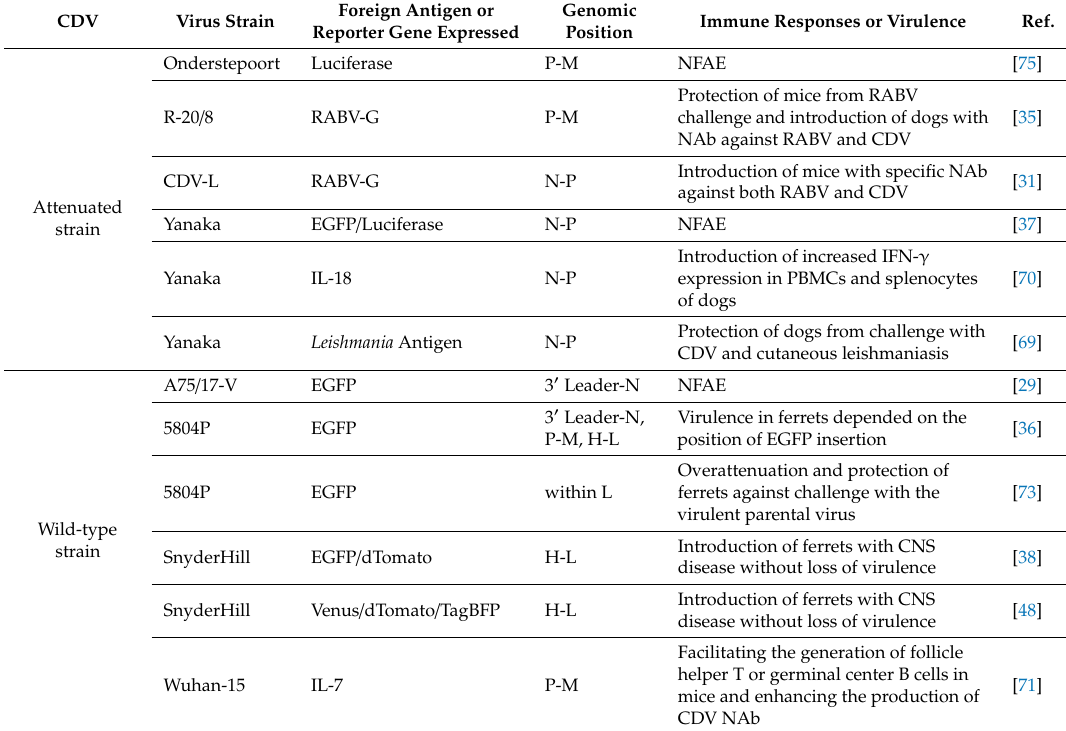
Table 1. Recombinant CDV generated using CDV reverse genetic system